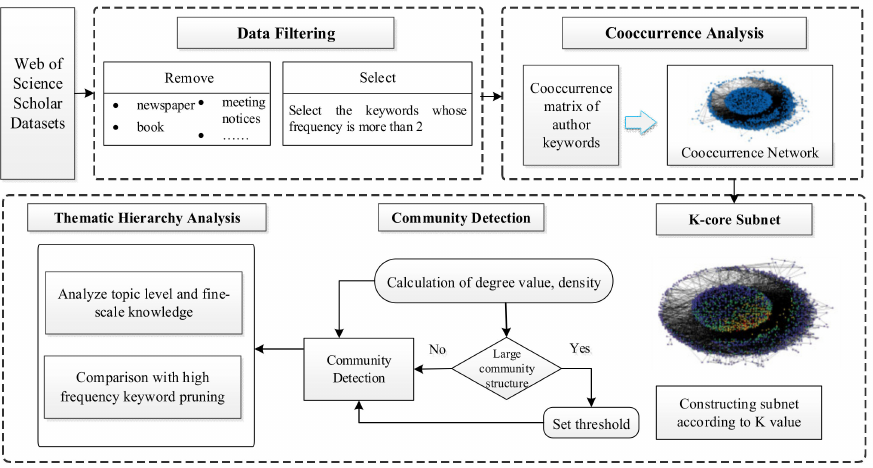
Figure 1. Technical research